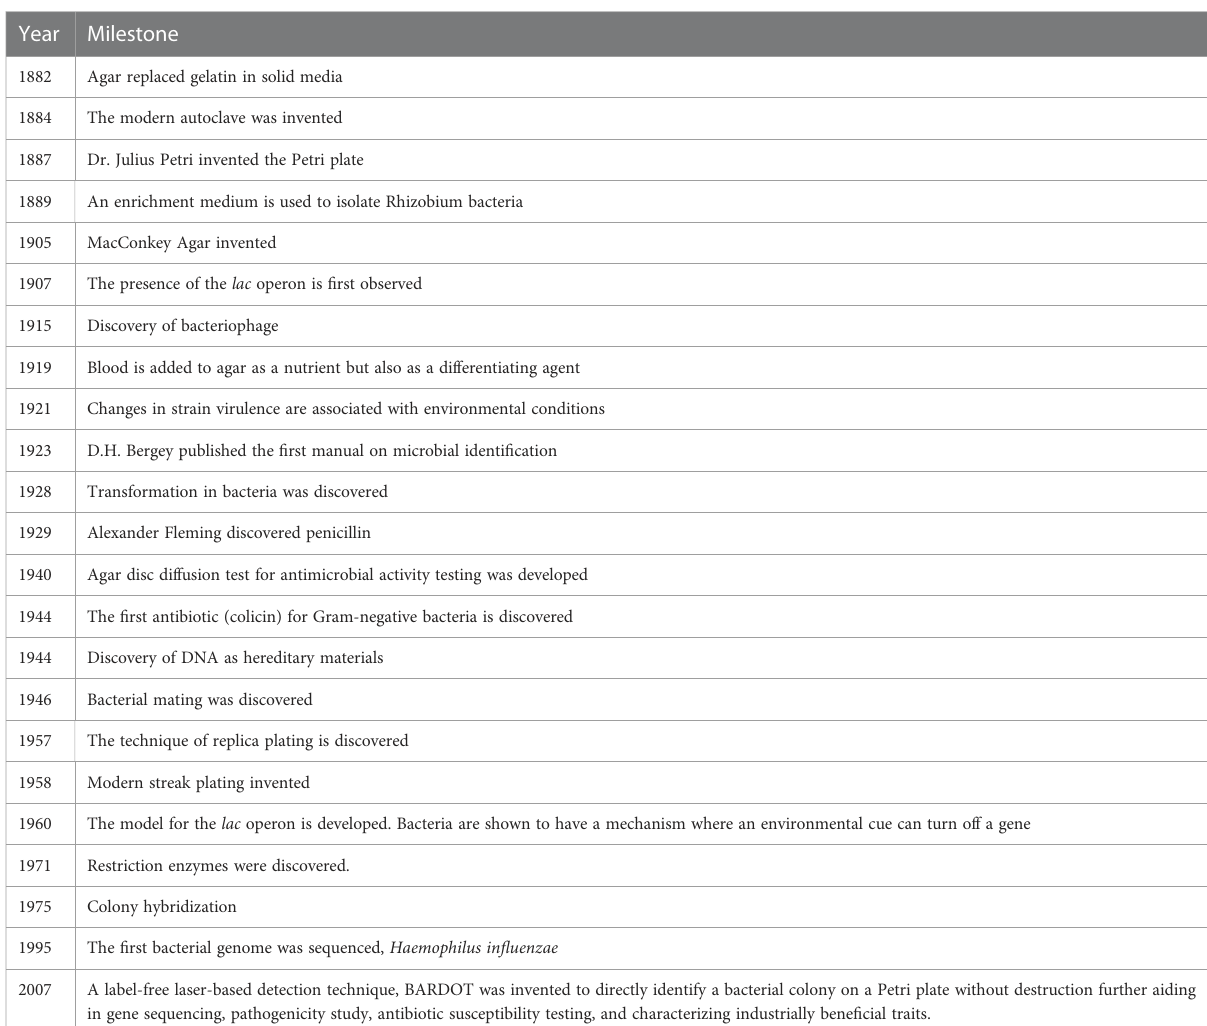
TABLE 1 Petri plate and microbiology